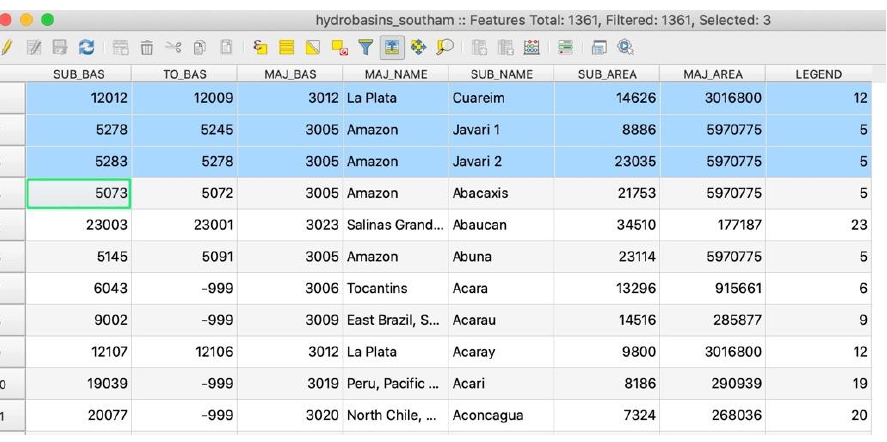
Figure 14. Alphanumeric data for basins and sub-basins available at Aquamaps (FAO).